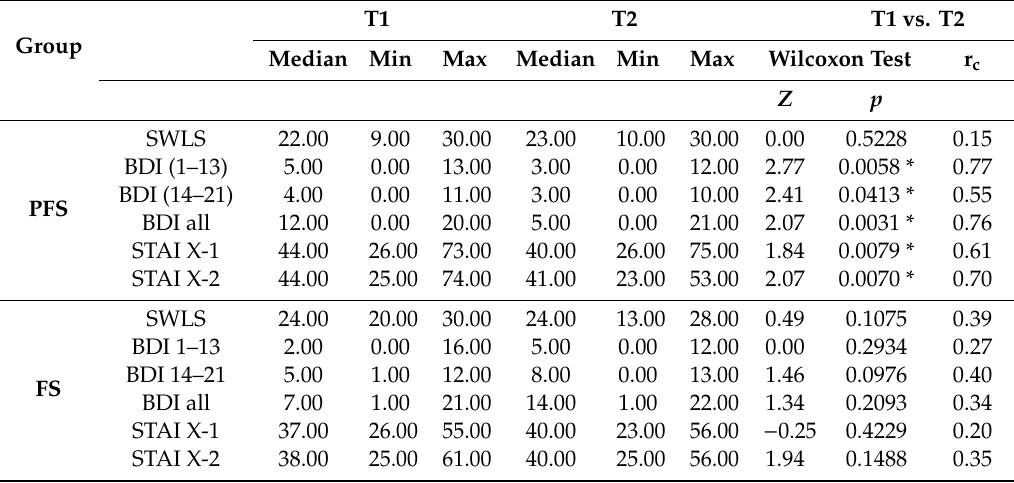
Table 3. Comparison of initial (T1) and final (T2) results in both groups (PFS and FS). T1 T2 T1 vs. T2 Group Median Min Max Median Min